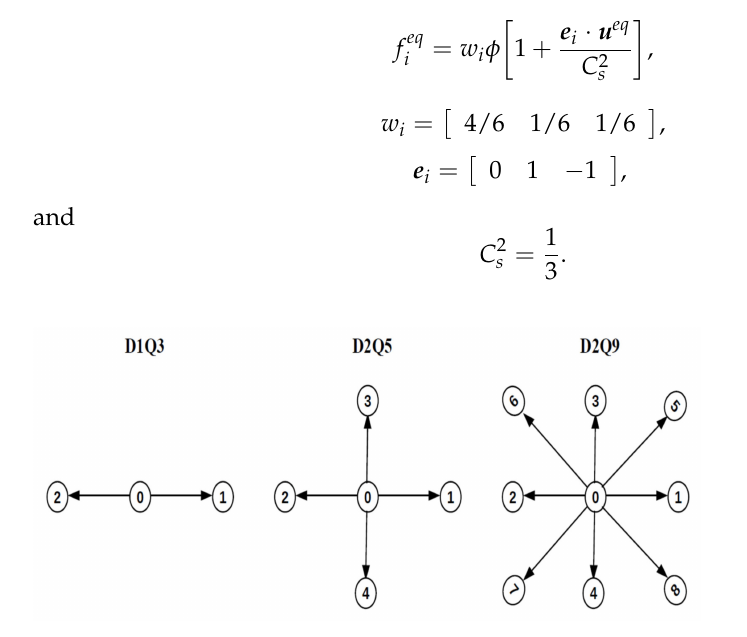
Figure 4. Schematic diagram of D1Q3, D2Q5, and D2Q9 lattice